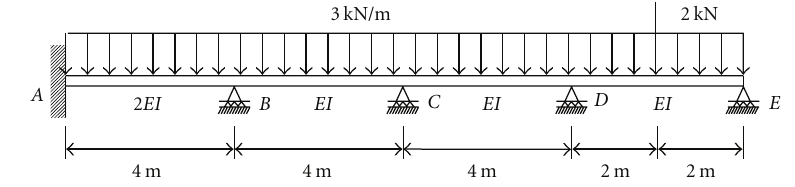
Figure 4: Continuous beam for the first example.